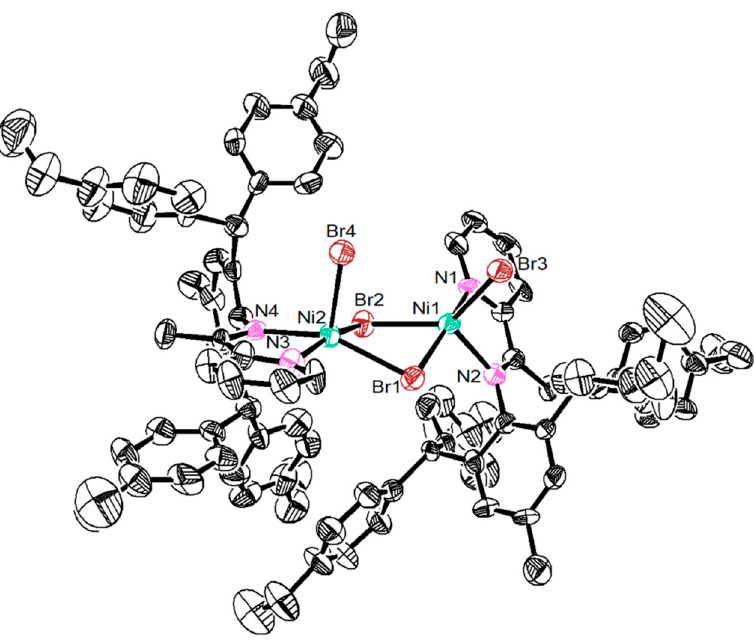
Figure 1. The single crystal structure of nickel complex Ni1 (CCDC: 2080105; 30% probability level), H atoms and solvent molecules have been omitted for clarity. Table 1. Effect of Catalysts and Temperatures on Ethylene Oligomerization.